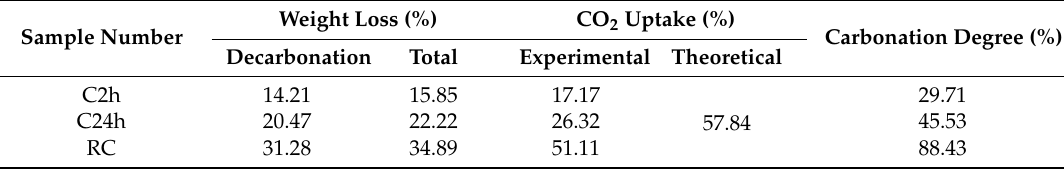
Table 3. Weight loss, CO 2 uptake, and carbonation degree of carbonation samples calculated by TG-DTG data.